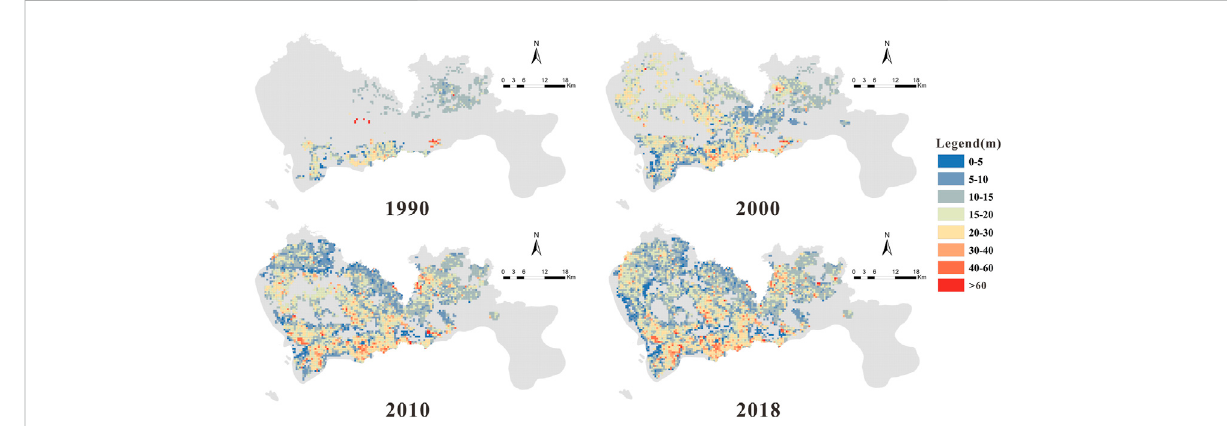
FIGURE 6 The average building height in Shenzhen from 1990 to 2018 (in 500 m × 500 m